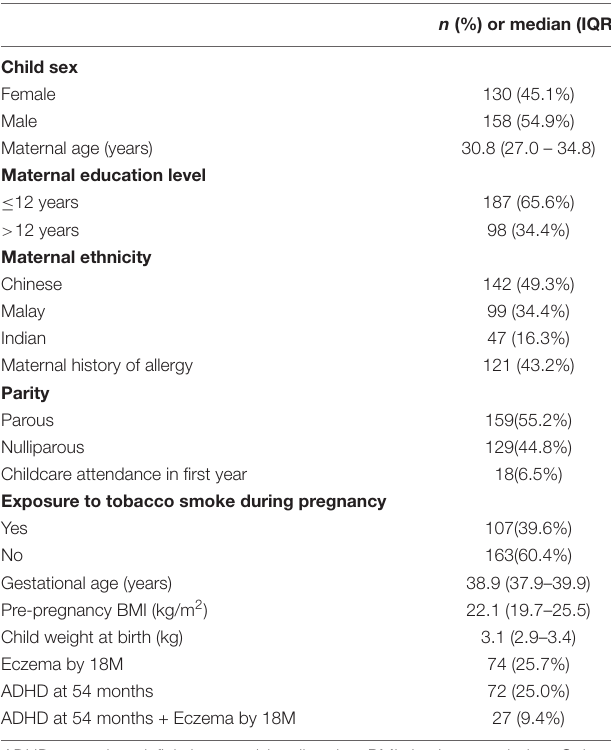
TABLE 1 | Characteristics of the study population ( n =